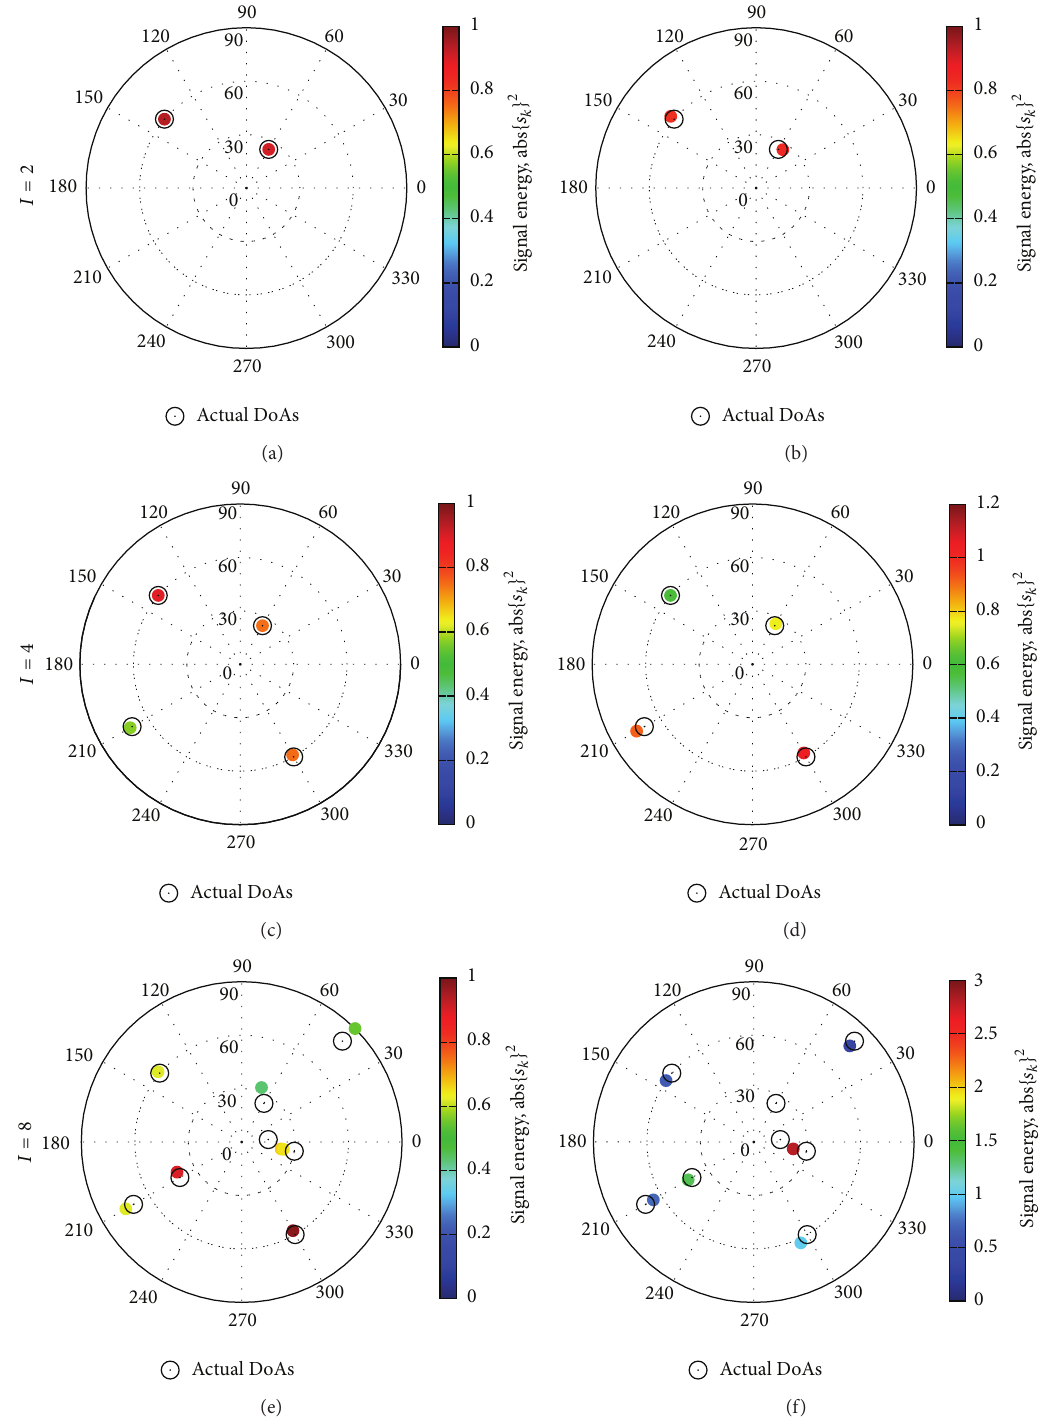
Figure 5: Fully populated array—( 𝑁 = 25 ; 𝑑 𝑥 = 𝑑 𝑦 = 0.5𝜆 ; 𝐼 ∈ [2 : 8] ; SNR = 10dB; 𝑇 = 2 ; 𝐶 = 50 )—plot of the best (left column) and worst (right column) estimations obtained by means of the MT-BCS among the 𝐶 different noisy scenarios when (a) (b) 𝐼 = 2 , (c) (d) 𝐼 = 4 , and (e) (f) 𝐼 = 8